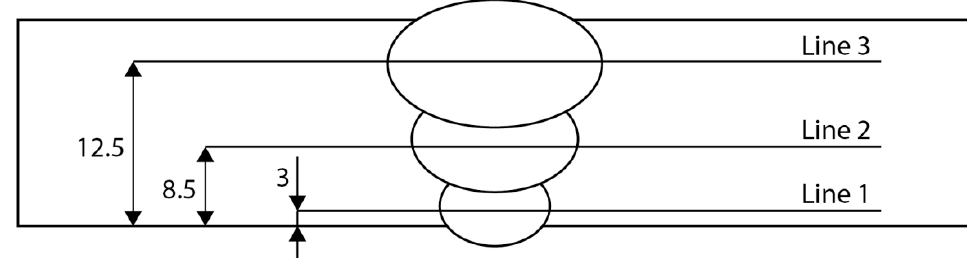
Figure 6. Schematic illustration of the hardness measurement zones (dimensions are in mm). For the single-bead specimens, the hardness values were measured in line 1 (3 mm from the bottom edge of the material), whereas the fusion line was taken as position 0. For the samples with two beads, hardness values were again measured in line 1 (3 mm from the bottom edge of the material and positioned as for the samples with one bead). This allowed the effect of the second bead on the changes in HAZ to be assessed. Line 2 was then created at a distance of 8.5 mm from the bottom edge of the sample and position 0 was taken as the intersection of line 2 and the second bead. Line 3 was then made at a